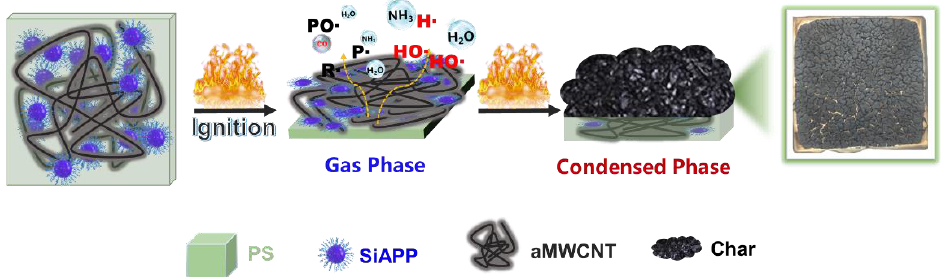
Figure 9. Schematic illustration for the proposed flame-retardant mechanism.